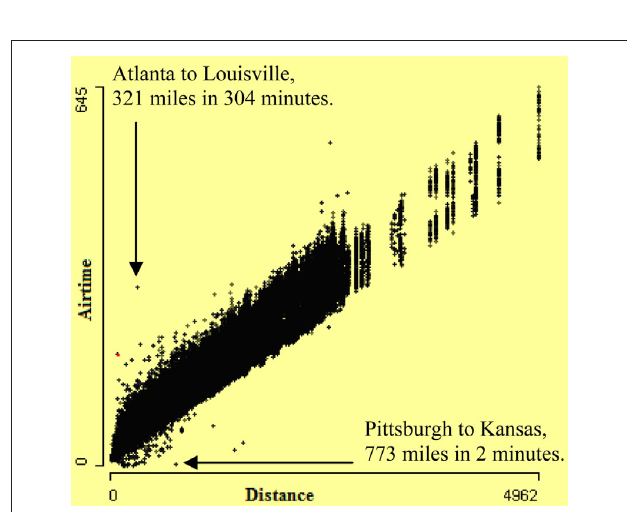
FIgurE 2 | Scatterplot of arrival time by departure time after converting arrival time into a 48-h scale. The gap in the strip may be due to many airports closed at